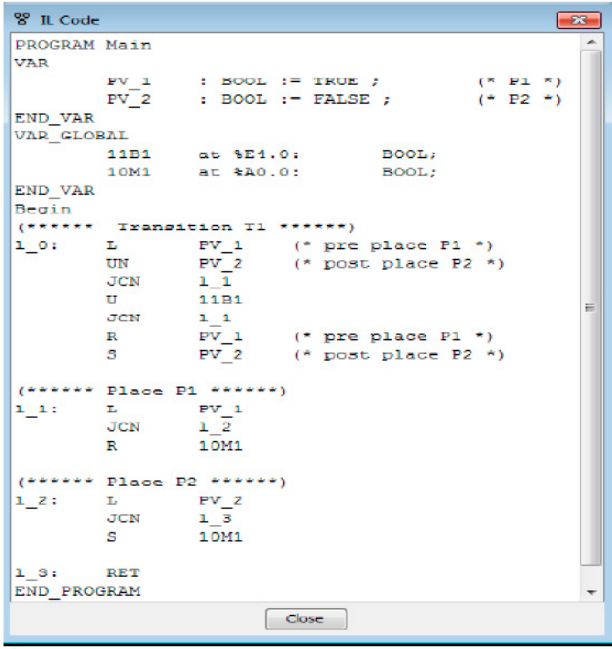
Figure 7. A screenshot of the generated code.